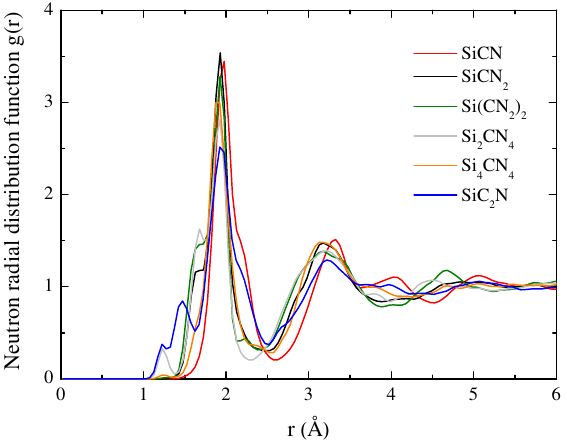
Figure 3. Partial radial distribution function of a-SiCN.